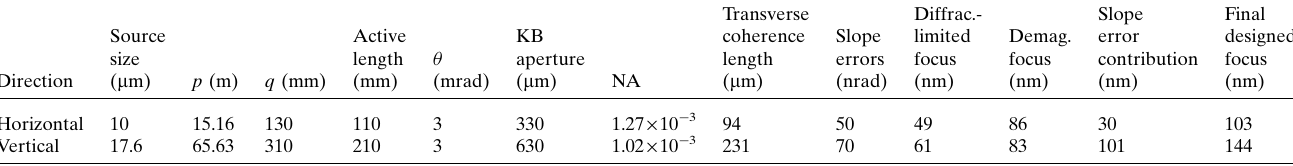
Table 1 Summary of the SRX’s nano-KB mirror parameters. Energy-dependent parameters such as the transverse coherence length and diffraction-limited focus size are evaluated at 10 keV. Under routine operation conditions, the horizontal source size, defined by the secondary source aperture, ranges from 100 to 10 m m. In the vertical direction, the KB mirrors operate on the primary X-ray source from the IVU-22 undulator. Except for the slope errors, all relevant parameters are based on FWHM values. The value in the slope error contribution column indicates the broadening of the focus size due to the slope